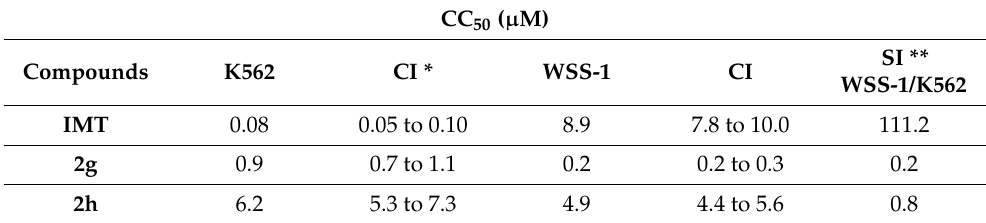
Table 1. CC 50 values in cell lines K562 and WSS-1 with confidence intervals (CI) and SI values for IMT and compounds 2g – h .